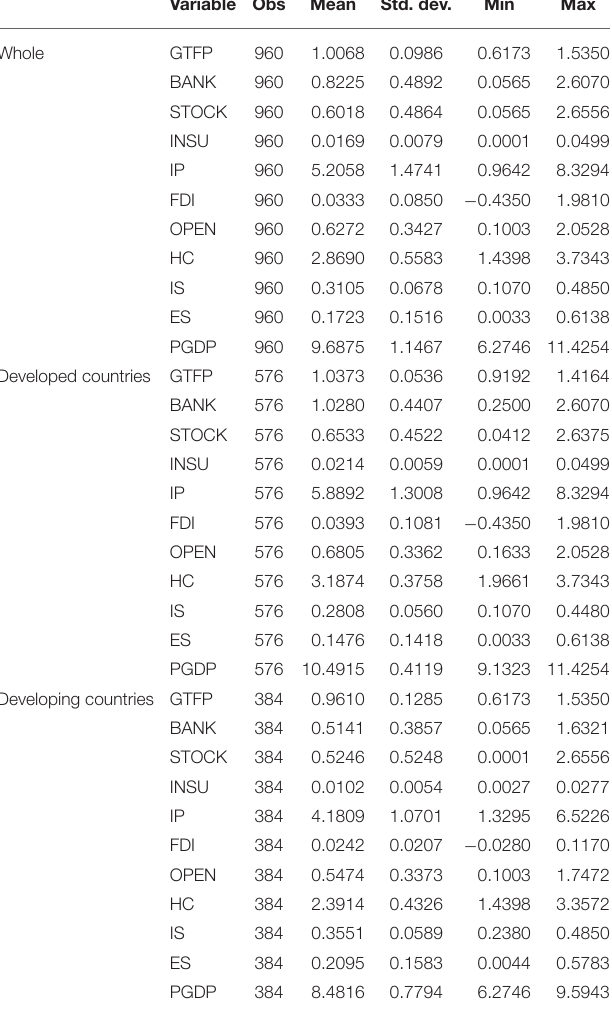
TABLE 1 | Descriptive statistics. Variable Obs Mean Std.